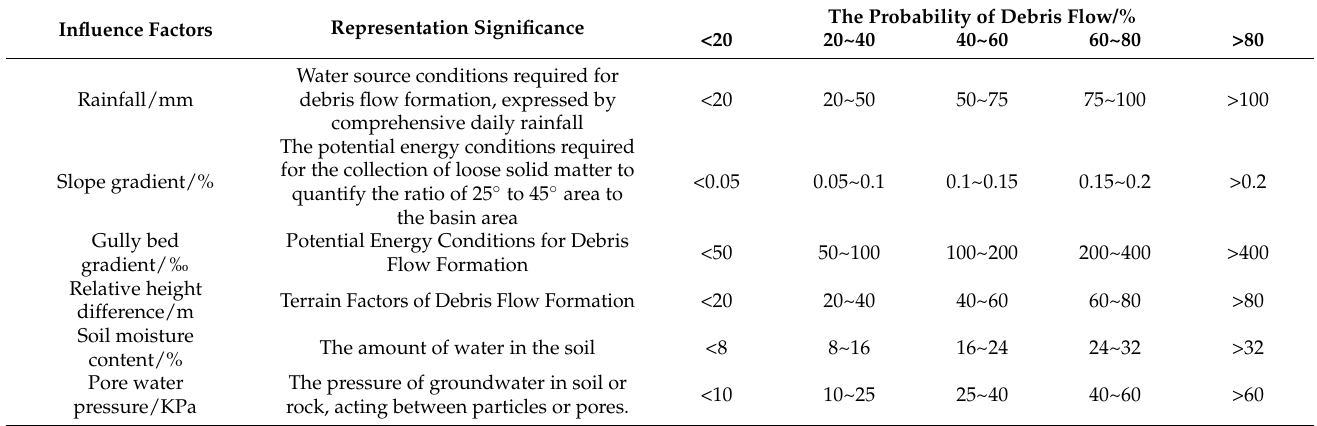
Figure 9. Relationship between influence factor dimensions and forecast accuracy. Table 2. Significance and classification of influence factors.